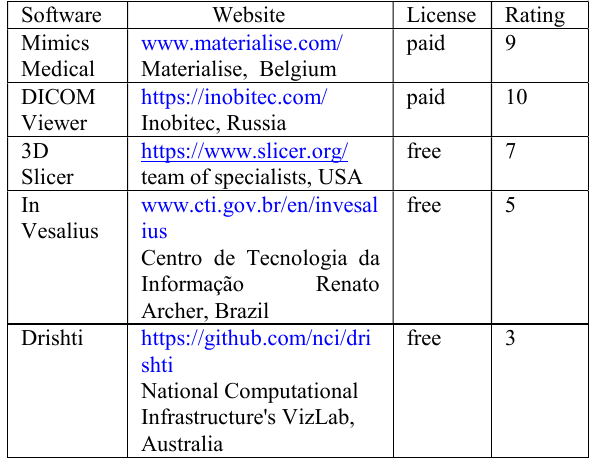
Table 1 . Software for processing and converting DICOM images into a three-dimensional model of the STL format.